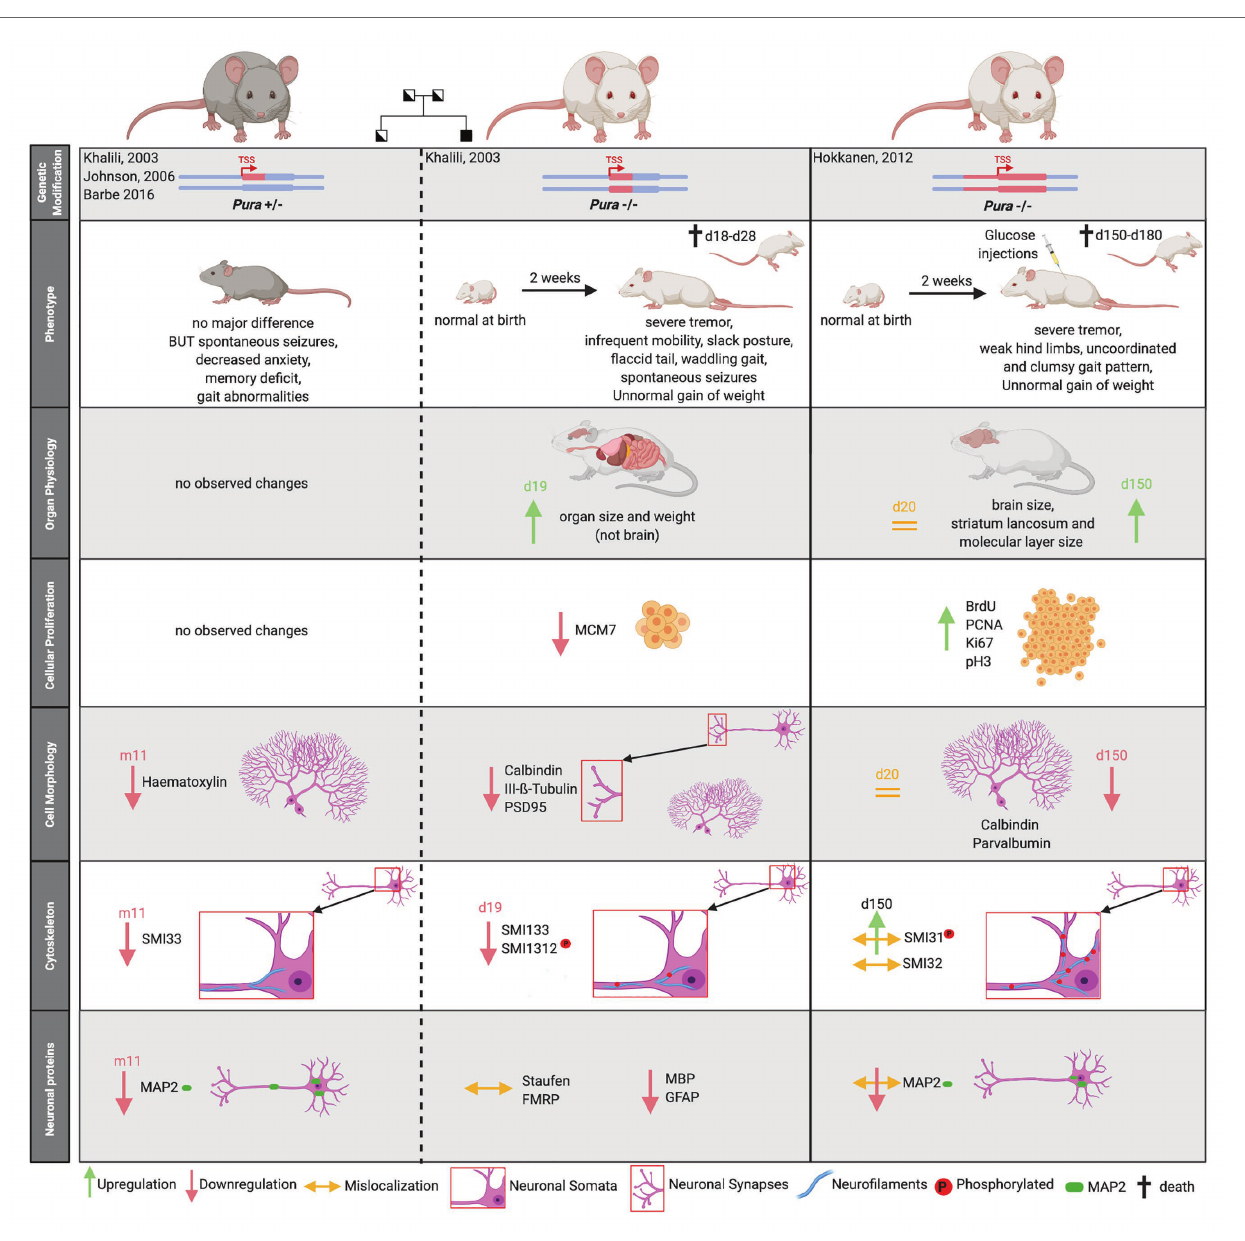
FIGURE 5 | Comparison of two published Pura knock-out mouse models. Heterozygous mouse models are indicated by gray fur color of the depicted mice, homozygouse by white fur color. The deleted genomic region around the transcription start site (TSS) is highlighted by red color. The mouse models are not only characterized by their clinical phenotype but also by their organ physiology. Specific biomarkers were used to study cellular proliferation, cytoskeleton, and the overall cell morphology in mouse brain. Proliferation markers: MCM7, BrdU, PCNA, and Ki67. Neurofilament markers: SMI33, SMI32 = non-phosphorylated neurofilament marker, SMI1312, SMI31 = phosphorylated neurofilament marker, Purkinje cell marker = Calbindin, and Neuronal Marker: Class III-ß-Tubulin. Synapse Marker in CA3 region = PSD95, Neuronal dendritic marker: Parvalbumin, MAP2, Unspecific nuclear staining = Hematoxylin. “d” indicates days, “m” indicates months after